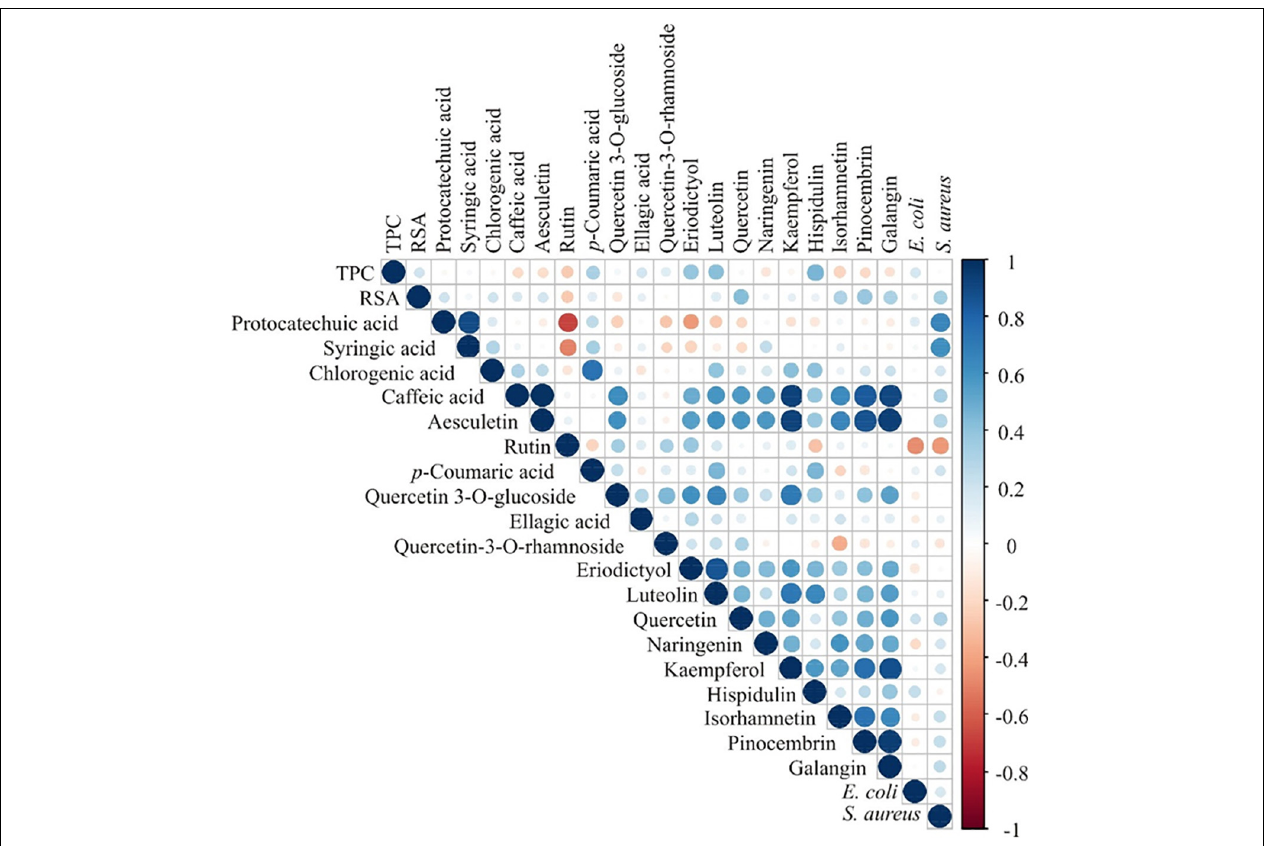
FIGURE 5 | Color correlation graph between the content of phenolic compounds, antioxidant activity (TPC and RSA) and antimicrobial activity.